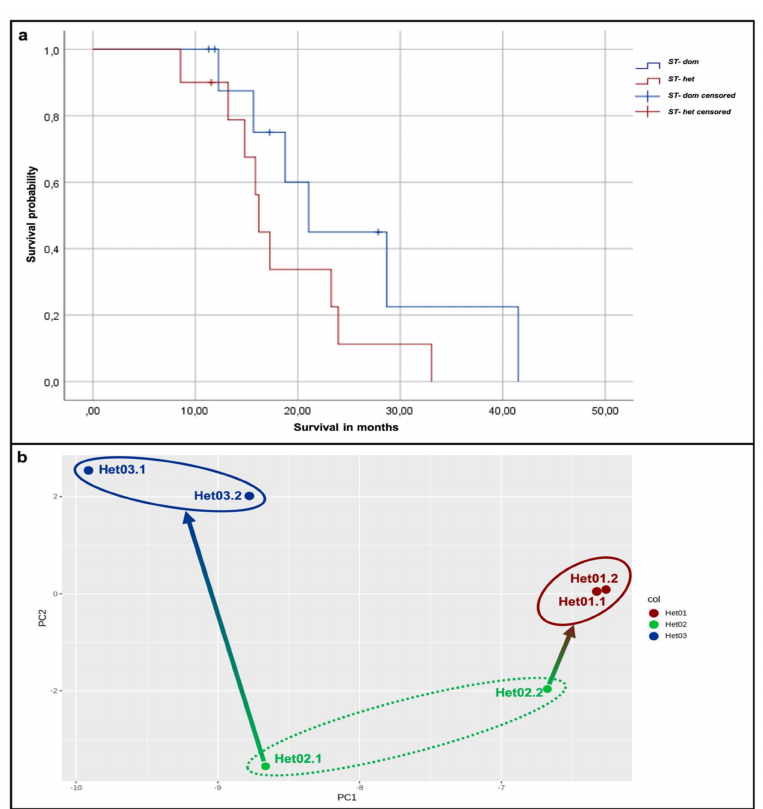
Figure 5. Survival analysis and principal component analysis (PCA) of epigenetic examination. ( a ): By Kaplan–Meier method, a shorter survival of patients with ST-dom tumors compared to patients with ST-het tumors can be observed ( p = 0.166). ( b ): The methylation profile of each two di ff erent AoI of three tumors was examined. PCA revealed a proximity of the both samples of tumors Het01 and